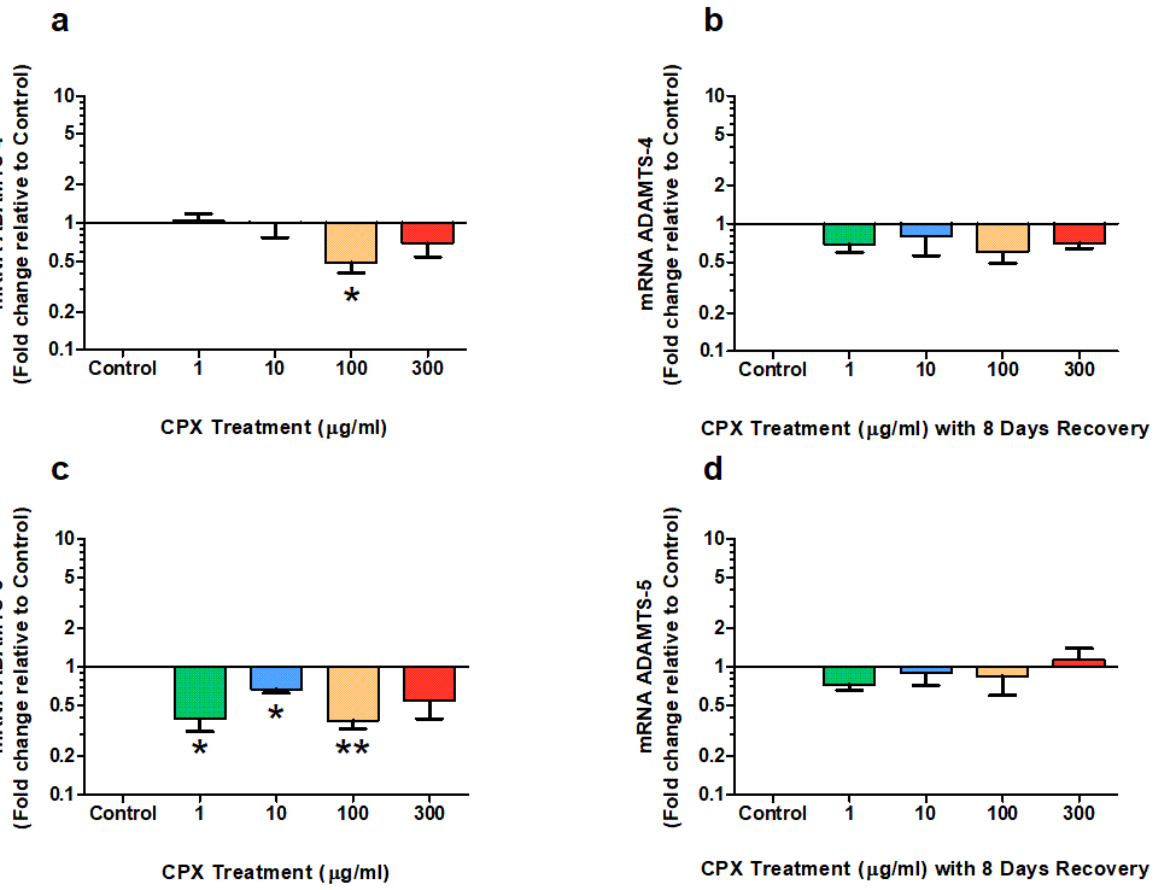
Figure 4. m RNA expression of ADAMTS-4 ( a , b ) and ADAMTS-5 ( c , d ) after 4 days treatment with 1, 10, 100 & 300 µg/mL CPX and subsequent 8-day recovery period in equine derived tendon explant cultures (n = 4). Results are expressed logarithmically. Values represent mean ± SEM and are expressed as fold change relative to control, normalised to GAPDH. * p < 0.05, ** p < 0.01 vs. control.